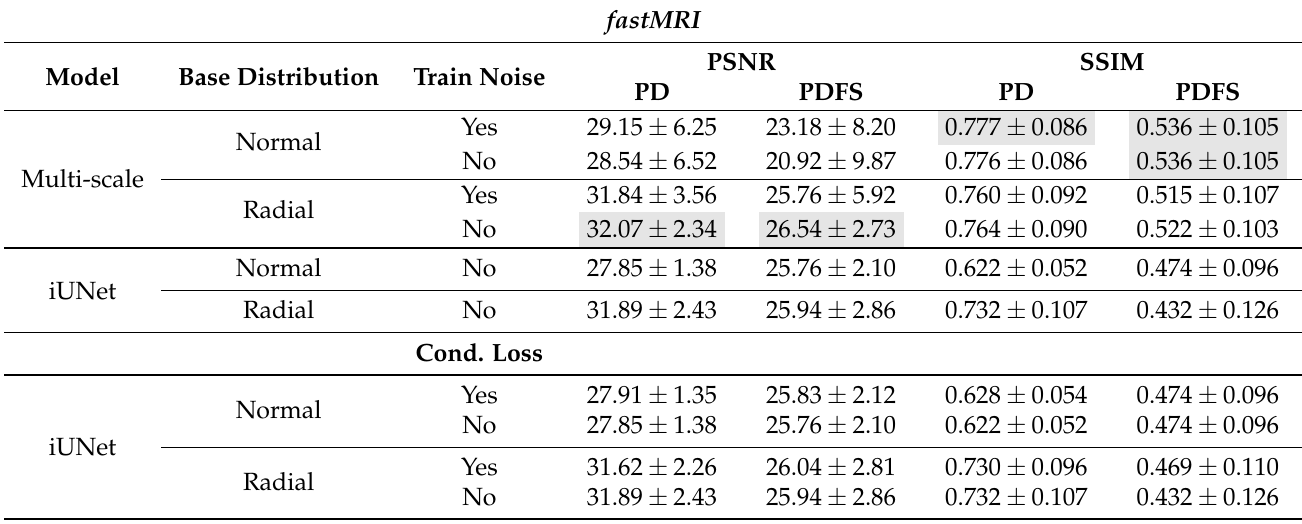
Table 5. Mean and standard deviation for the fastMRI dataset. Conditioned mean computed with 100 samples. Unless oth- erwise specified, no additional training noise and no cond. loss were